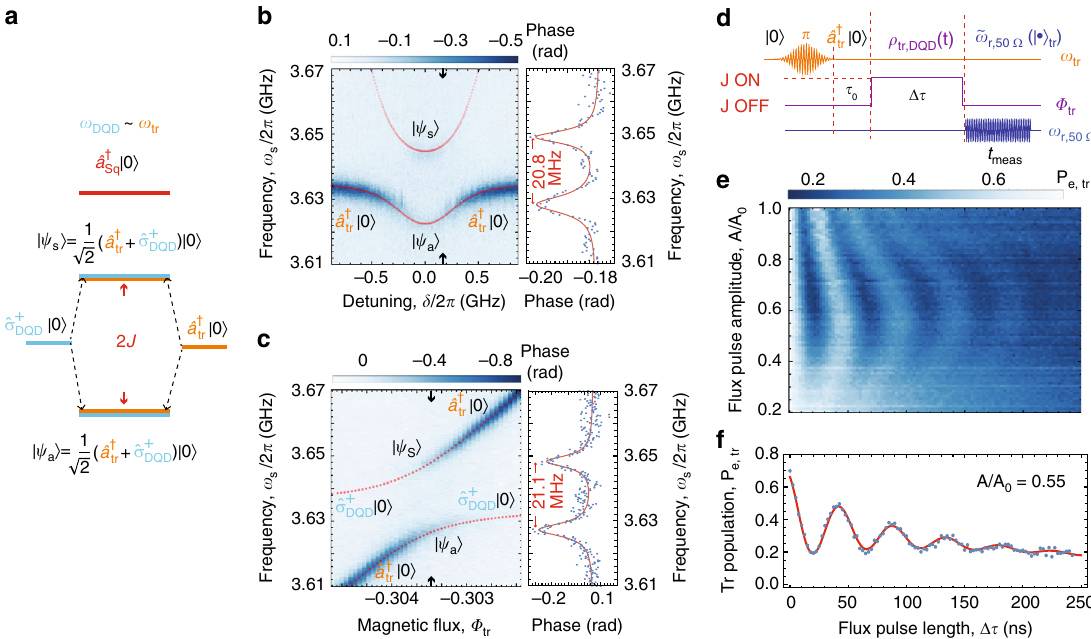
Fig. 3 DQD-transmon interaction mediated by virtual photon exchange in the SQUID array resonator. a Energy level diagram of the DQD-transmon j 0 iÞ , the transmon qubit coupling mediated via dispersive interaction with the SQUID array resonator (red line). The DQD excitation ð σ y DQD j 0 iÞ and the SQUID array resonator excitation ð a y j 0 iÞ are shown, together with their hybridized states | Ψ 〉 and the system vacuum excitation ð a y s,a tr Sq state |0 〉 = |0 〉 Sq ⊗ | g 〉 tr ⊗ | g 〉 DQD . b Left: spectroscopy of the DQD qubit interacting with the transmon. Phase Δ ϕ = Arg[ S 11 ] of a fi xed frequency measurement tone ω p /2 π = 6.5064 GHz = ω r,50 Ω /2 π re fl ected off the 50 Ω CPW read-out resonator vs. transmon qubit spectroscopy frequency ω s and DQD qubit detuning δ [( c ) the fl ux through the SQUID loop of the transmon Φ tr ]. Right: phase Δ ϕ = Arg[ S 11 ] response at the DQD detuning δ [(c) at the fl ux Φ tr ] indicated by the black arrows in left panel showing a coupling splitting of 2 J ~20.8 ± 0.3 MHz [2 J ~21.1 ± 0.2 MHz]. d Pulse protocol for the population transfer between the transmon and the DQD charge qubit. ρ ( t ) indicates the density matrix of the coupled transmon-DQD system ¼ ω þ g 2 = Δ during the interaction time Δ τ and ~ ω . τ 0 is a fi nite time difference between the preparation pulse and the fl ux pulse. r ; 50 Ω r ; 50 Ω tr ; 50 Ω tr ; 50 Ω e Average transmon excited state population P e,tr (each data point is the intergrated average over 50,000 repetitions of the experiment), as a function of the fl ux pulse length Δ τ and normalized fl ux pulse amplitude A / A 0 . f Transmon excited state population P e,tr vs. Δ τ for a fl ux pulse amplitude of A / A 0 = 0.55, for which the transmon is approximately in resonance with the DQD ( ω tr /2 π ~ ω DQD /2 π = 3.660 GHz). ω r,Sq /2 π = 4.060GHz and ω π = 6.5048 GHz. The red line is a fi t to a Markovian master equation model (see Supplementary Note 6 for more r,50 Ω /2